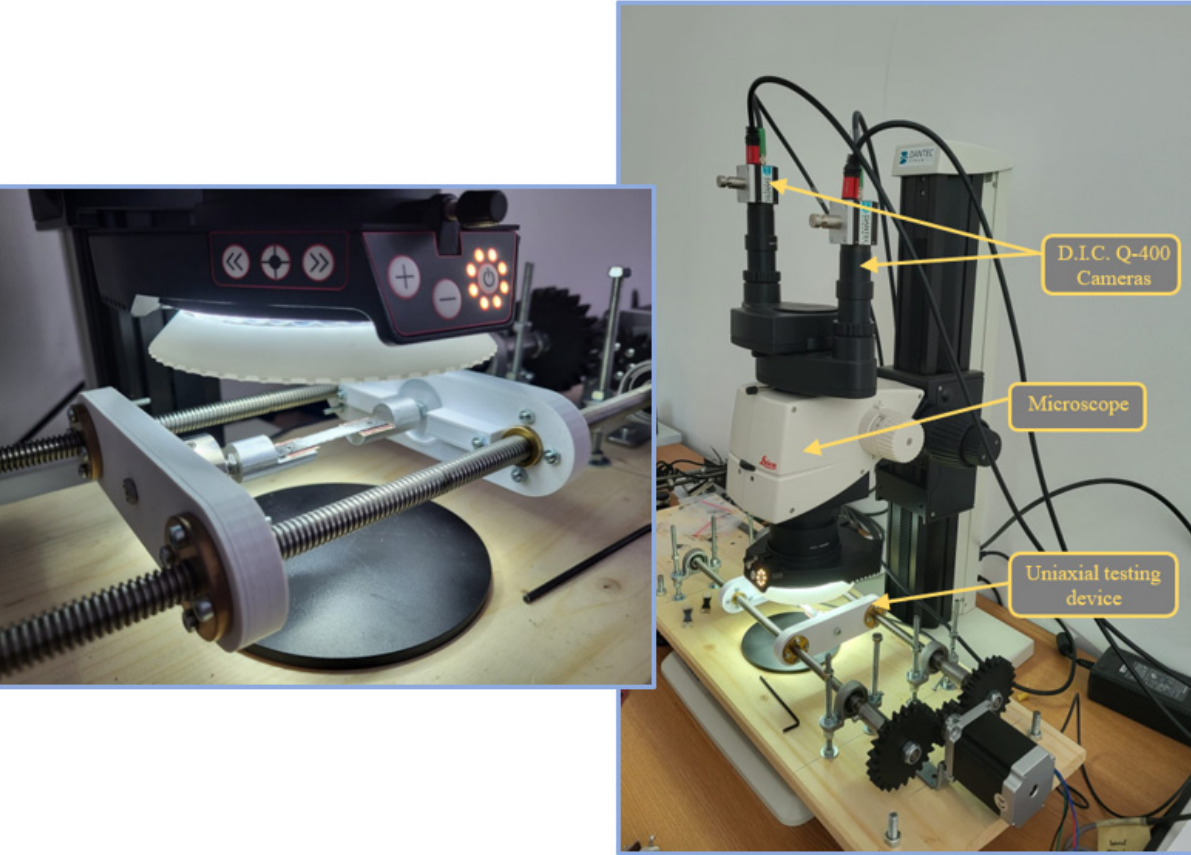
Figure 3. Visualization equipment placed over the specimen fastened in the uniaxial testing device.